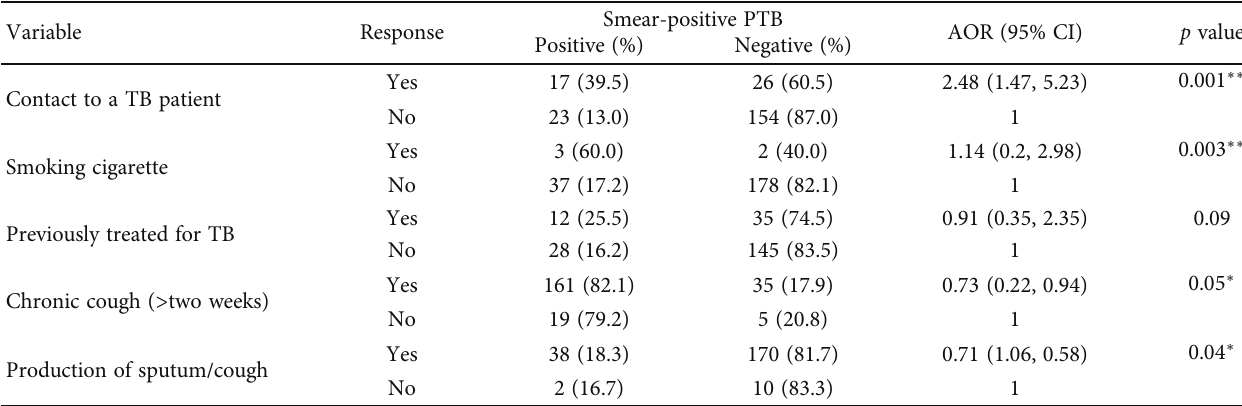
Table 3: Multivariable analysis of risk factors signi fi cantly associated with smear-positive